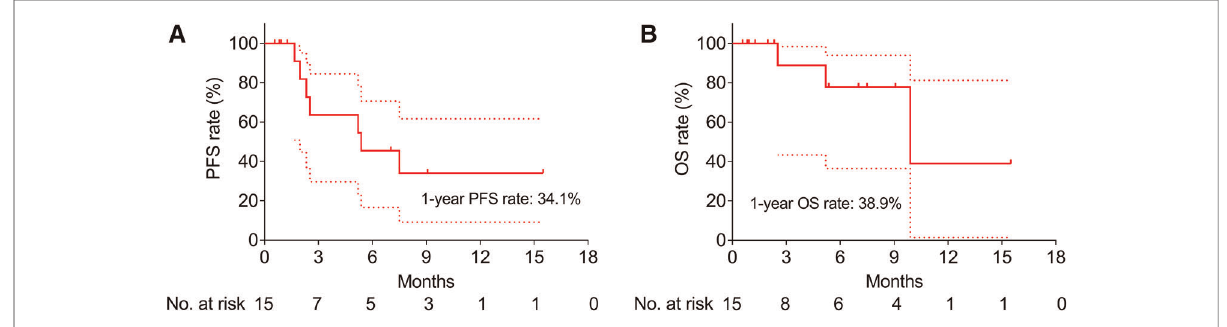
FIGURE 1 Survival of HNC patients after CSM-TACE. PFS ( A ) and OS ( B ) among HNC patients after CSM-TACE. PFS, progression-free survival; OS, overall survival; HNC, head and neck cancer; CSM-TACE, transarterial chemoembolization with CalliSpheres® Microspheres; dotted line, 95% con fi dence interval.